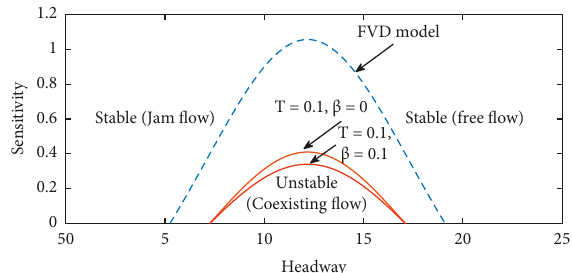
Figure 2: Phase diagram space of IH model in the parameter